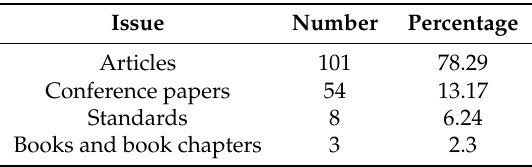
Table 2. Analysis on the literature used in the